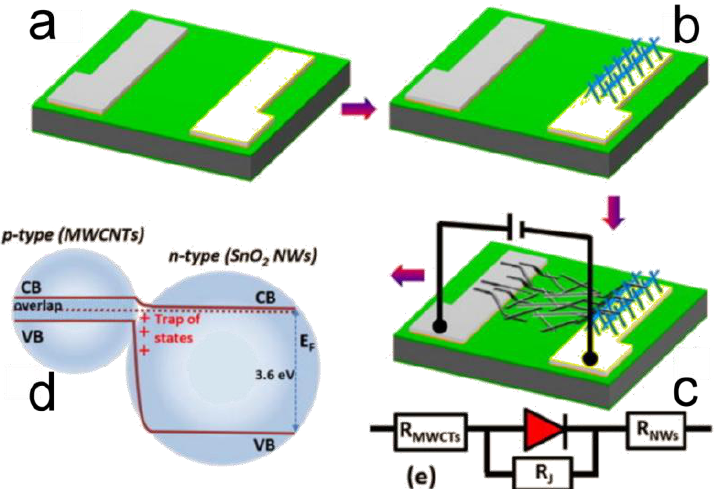
Figure 3. Scheme for fabrication of the hybrid heterojunction of MWCNTs and SnO 2 nanowires (NWs): ( a ) a pair of Pt-electrodes, ( b ) selective growth of SnO 2 NWs, ( c ) the deposition of MWNCTs to form the heterojunction, ( d ) band diagram of the heterojunctions, and ( e ) equivalent electronic. Reprinted from Ref. [61], with the permission of AIP Publishing.